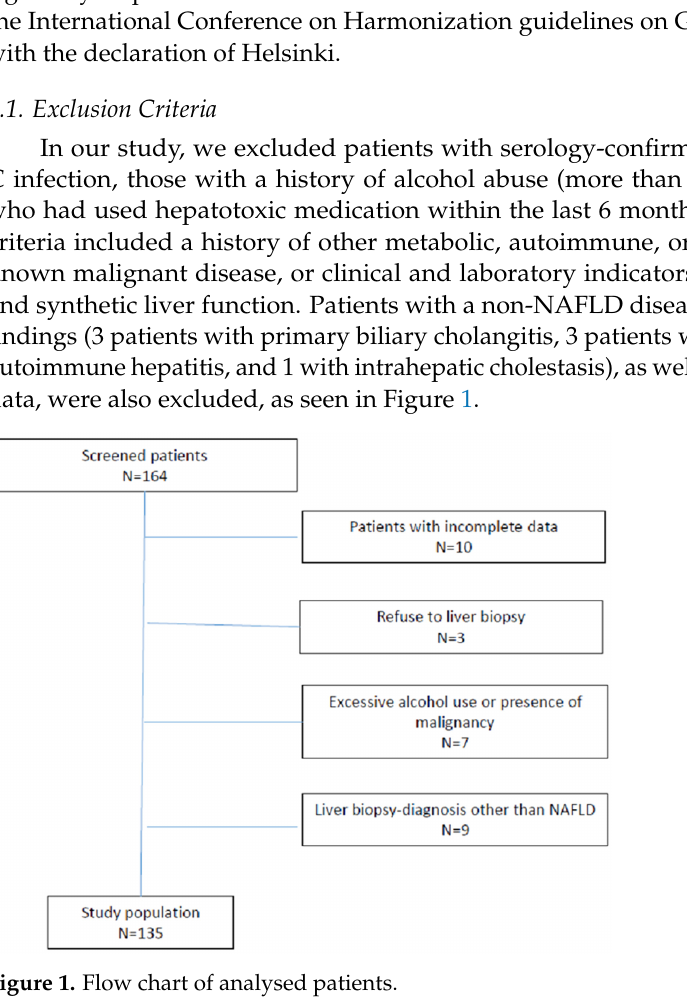
Figure 1. Flow chart of analysed